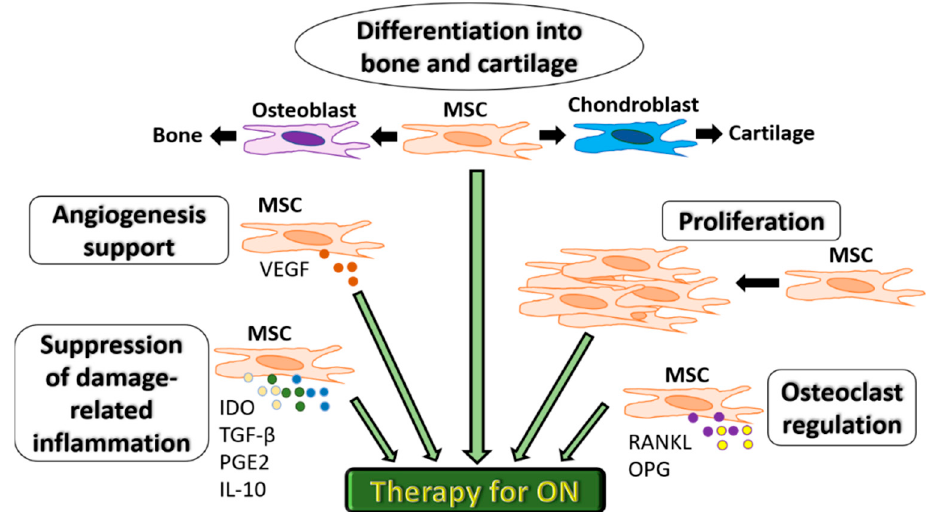
Figure 2. Functional characteristics of MSCs for therapeutic use in ON. MSCs can differentiate into bone or cartilage, support angiogenesis via VEGF secretion, proliferate to compensate for bone cell death, regulate osteoclastogenesis via RANKL and OPG and suppress inflammation associated with tissue damage via the production of immunosuppressive factors IDO, TGF ‐β , PGE ‐ 2 and IL ‐ 10.MSC: mesenchymal stromal cells. IDO: indoleamine 2,3 dioxygenase.